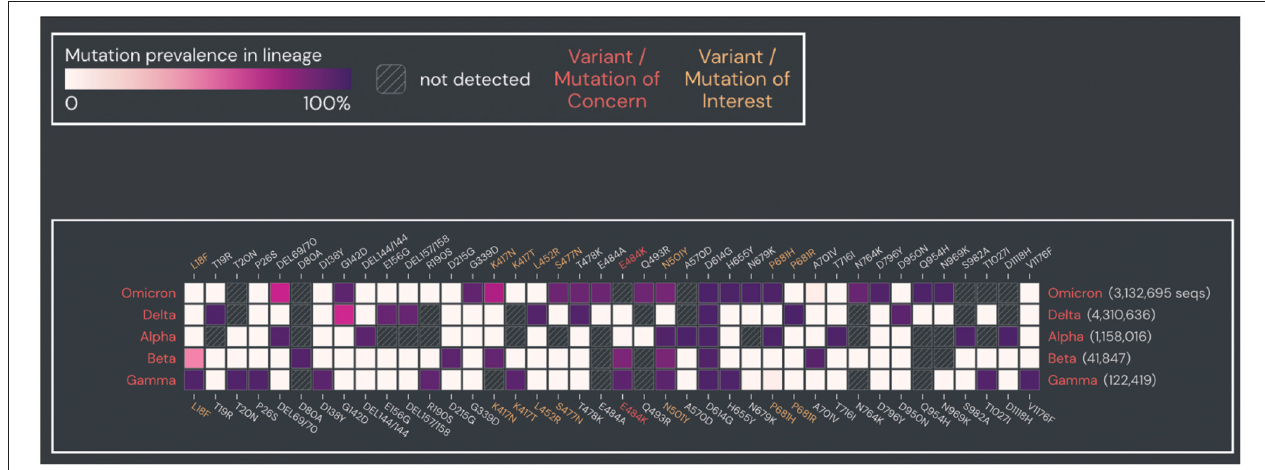
FIGURE 1 | Prevalence of spike protein mutations in Omicron compared to other SARS-CoV-2 VOCs. Prevalence of spike protein mutations in Omicron compared to four SARS-CoV-2 VOCs (Alpha, Beta, Gamma, Delta). Mutations with > 90% prevalence in at least one SARS-CoV-2 VOC and within > 2 sequences are shown. Plot was generated from the outbreak website (https://outbreak.info/). Data were obtained from GISAID (as of 25 April